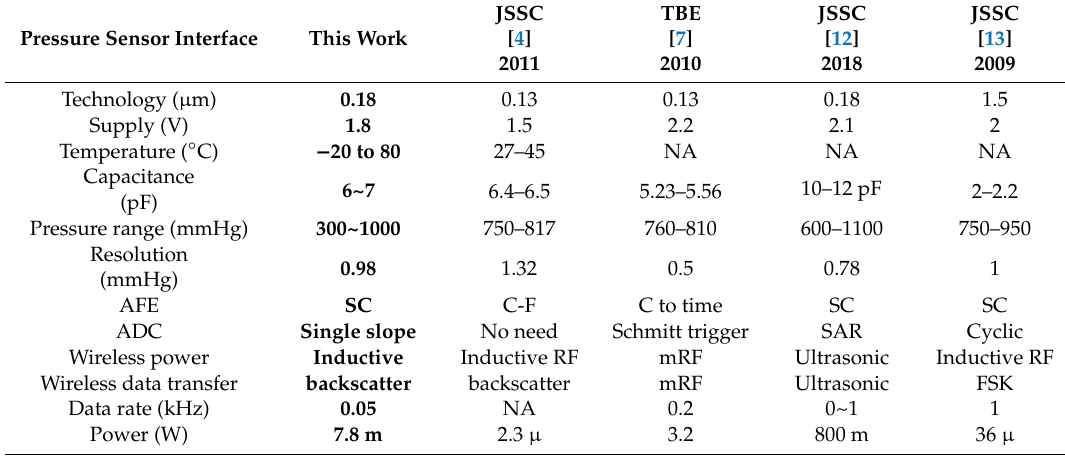
Table 1. Performance comparison of the interface circuits.